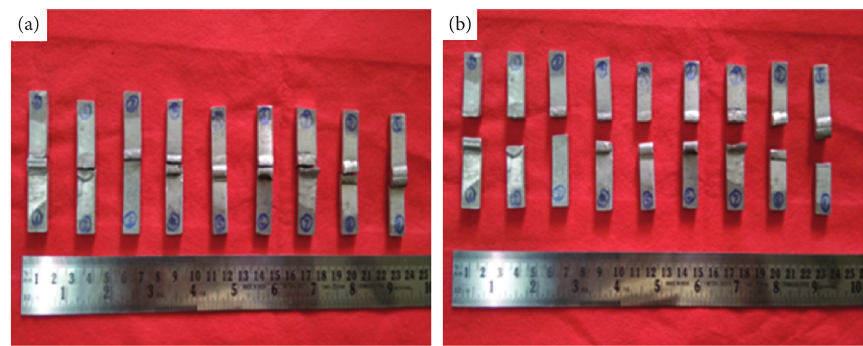
Figure 3: Impact test specimens (a) before testing and (b) after testing.